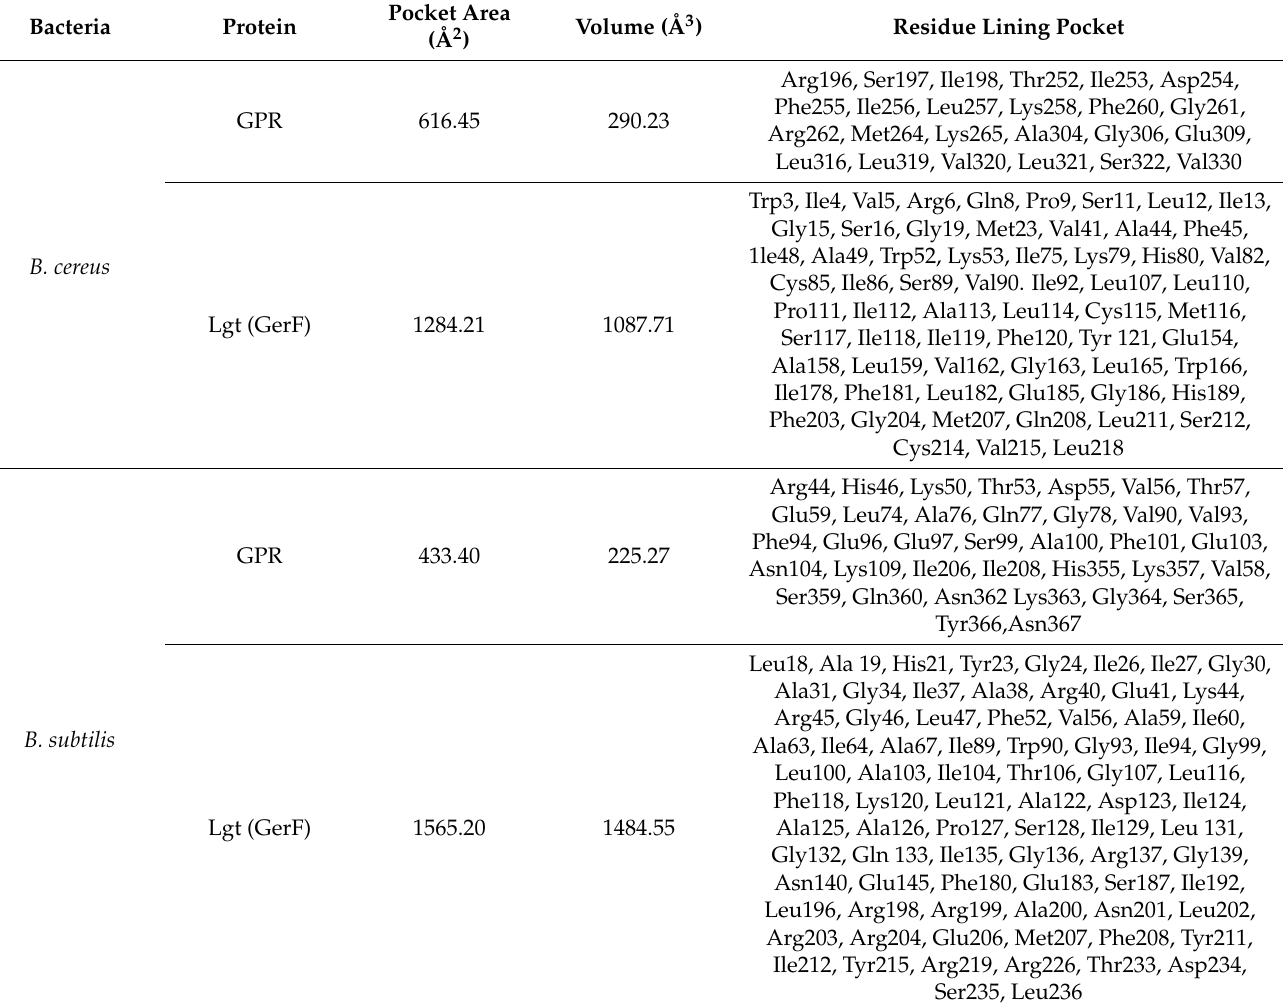
Table 4. Binding pocket prediction and analysis of conserved germination protein via CASTp. The predicted binding pocket includes the pocket area, volume, and residues lining the pocket of conserved germination